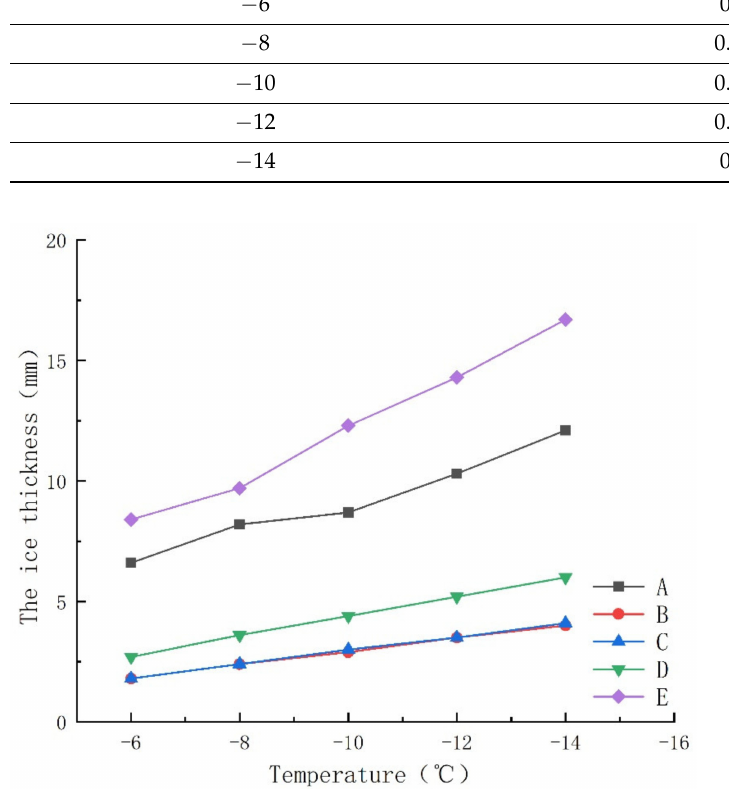
Figure 9. The changes of ice thickness at different